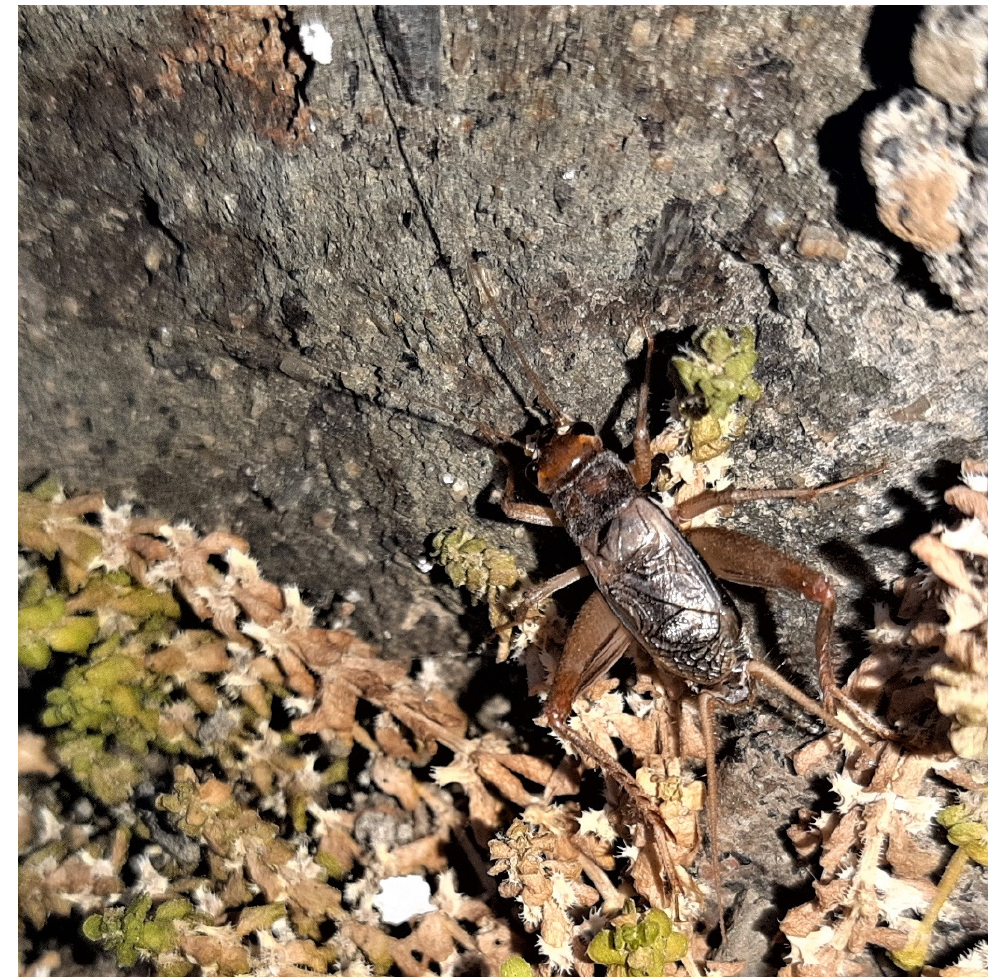
Figure 4. Live male specimen of Pantelleria Cricket Acheta pantescus n. sp. as photographed at the lighthouse of Punta Limarsi on 14 May 2022.